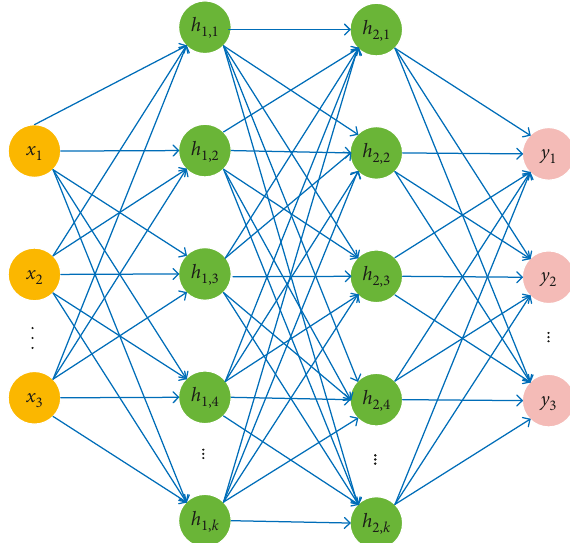
Figure 5: Artificial neural network